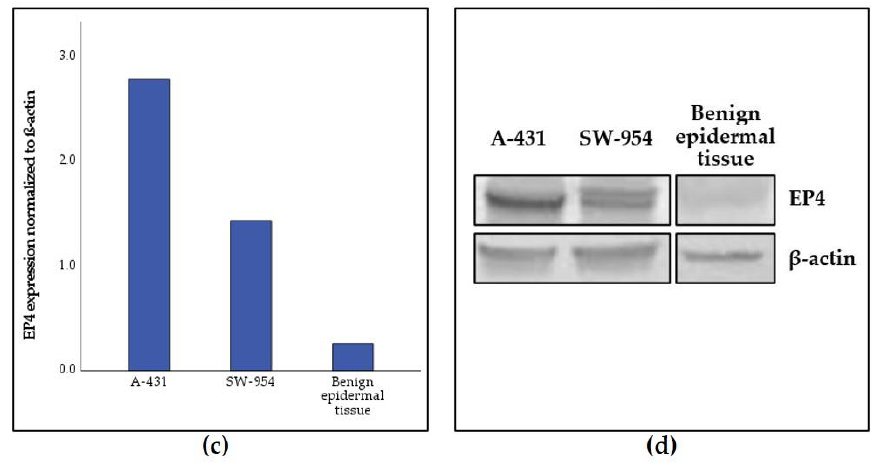
Figure 4. Incubation of vulvar carcinoma cells with L-161,982. ( a ) 3-(4,5-Dimethylthiazol-2-yl)-